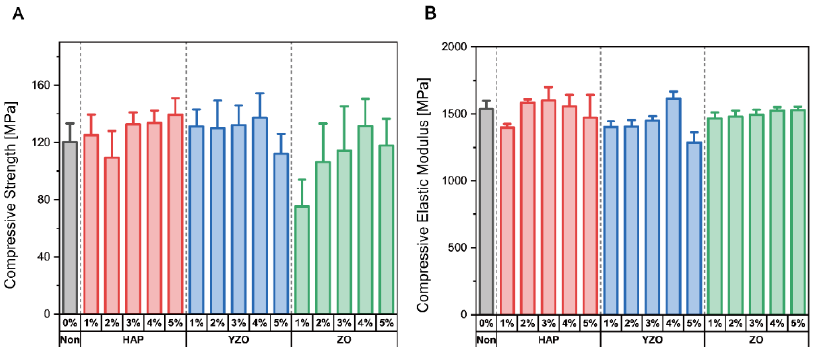
Figure 2. Results of the compression test on different types of bioceramic–epoxy composite materials. ( A ) Compressive strength. ( B ) Compressive elastic modulus.